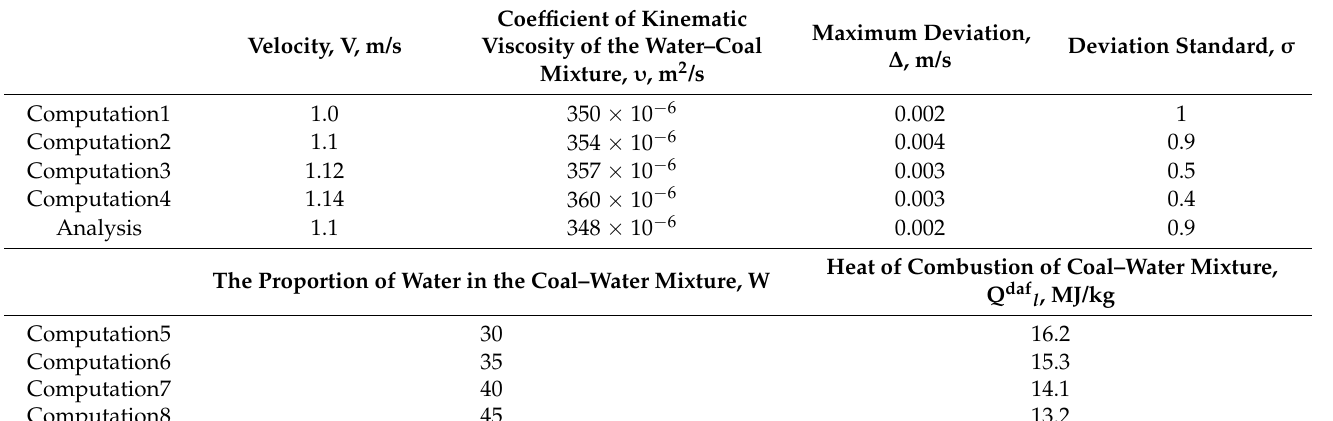
Figure 12. The results of using the new mathematical modeling. Table 3. The results of analytical calculations and analysis according to the developed method.